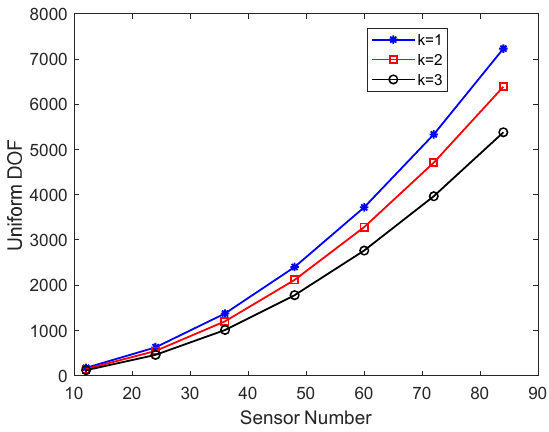
Figure 7. The uniform DOF versus k .